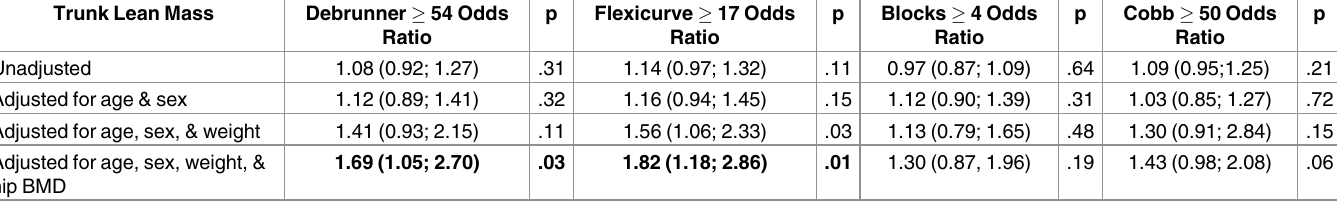
Table 4. Logistic regression results of the association of trunk lean mass and hyperkyphosis. Trunk Lean